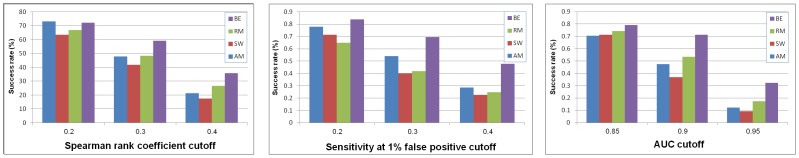
Success rates in probe ranking of a paired PBM.For each TF and method, the PWM was learned using one array and used to infer probe intensity ranking in its paired array. Ranking was gauged on a set of top positive probes (4σ set) according to three measures: Spearman rank coefficient, sensitivity at 1% false positive and AUC (see Methods S1 for all mathematical terms). For each quality measure, three distance cutoffs were used, and the fraction of TFs with score equal or better to the cutoff is the success rate. The results show the success rate over 230 samples (115 paired arrays).